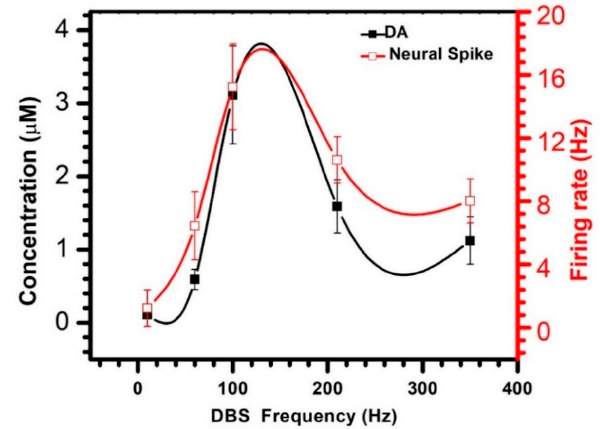
Figure 5. Mean increase variation of DA concentration and neural spike firing rate at the di ff erent frequency